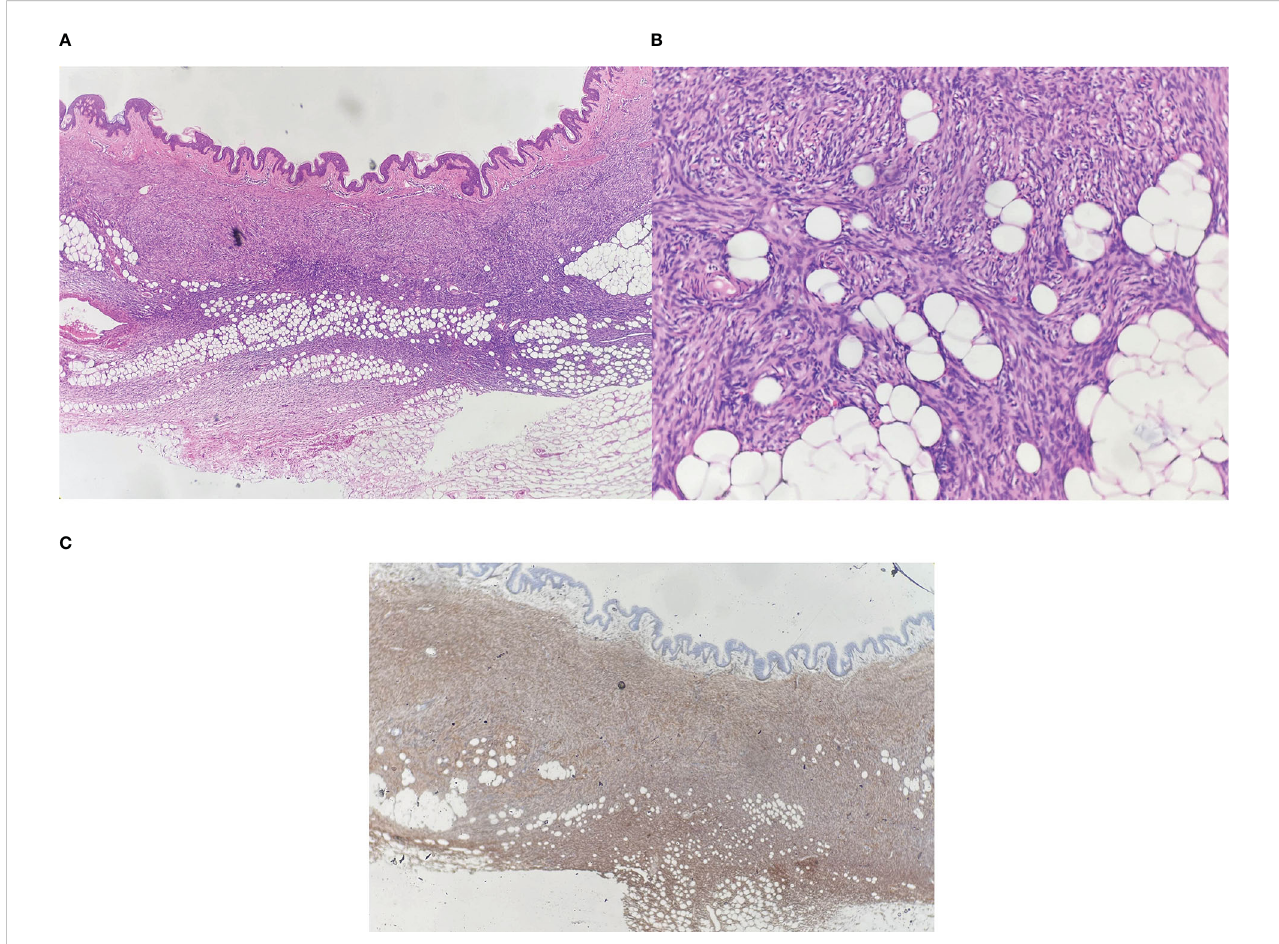
FIGURE 2 (A) Spindle cells in fi ltrate into the deep dermis and subcutaneous tissue, Hematoxylin-eosin (HE) ×40; (B) Dense proliferation of spindle cells in a storiform pattern, HE ×100; (C) Spindle cells are strongly positive for CD34,